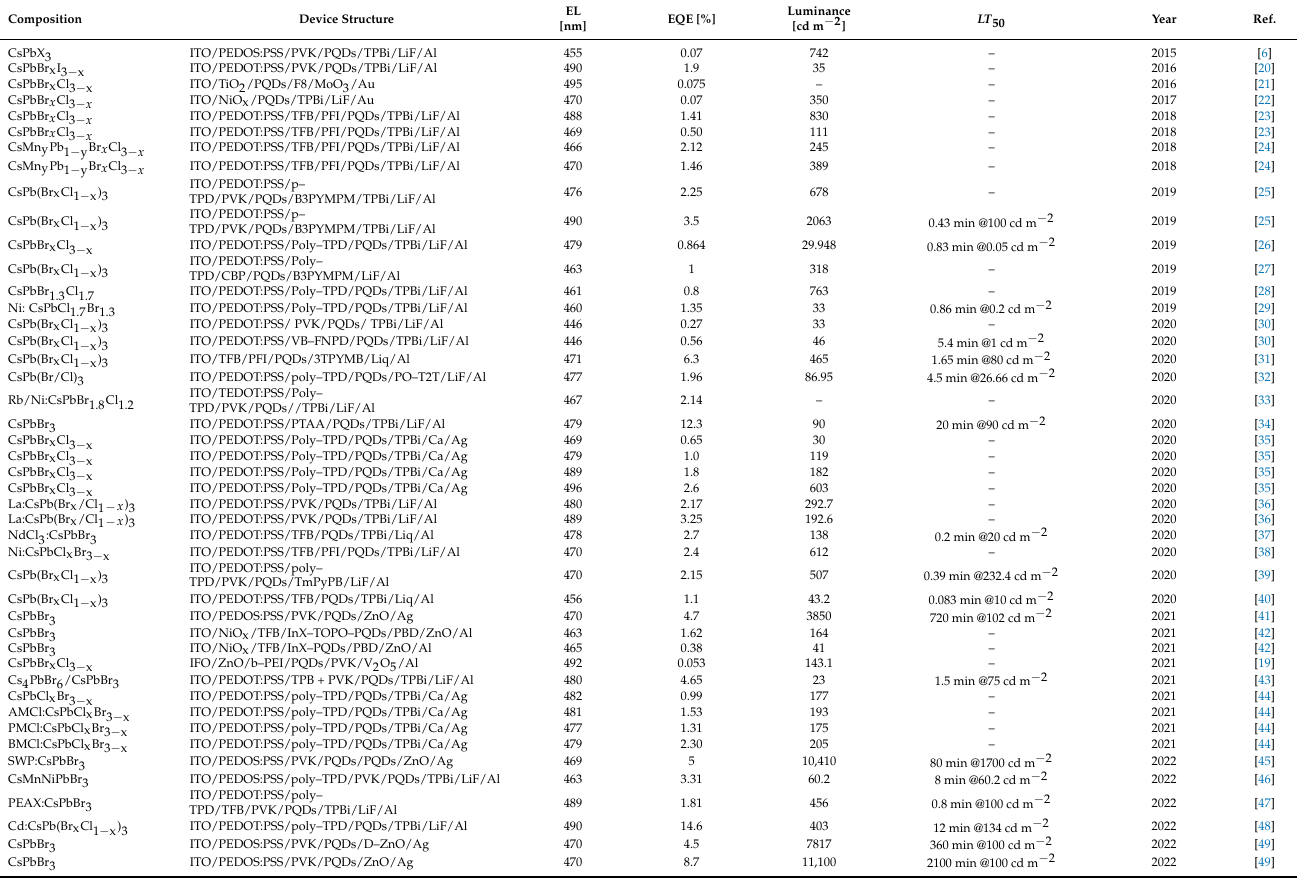
Table 1. The key parameters of currently reported blue